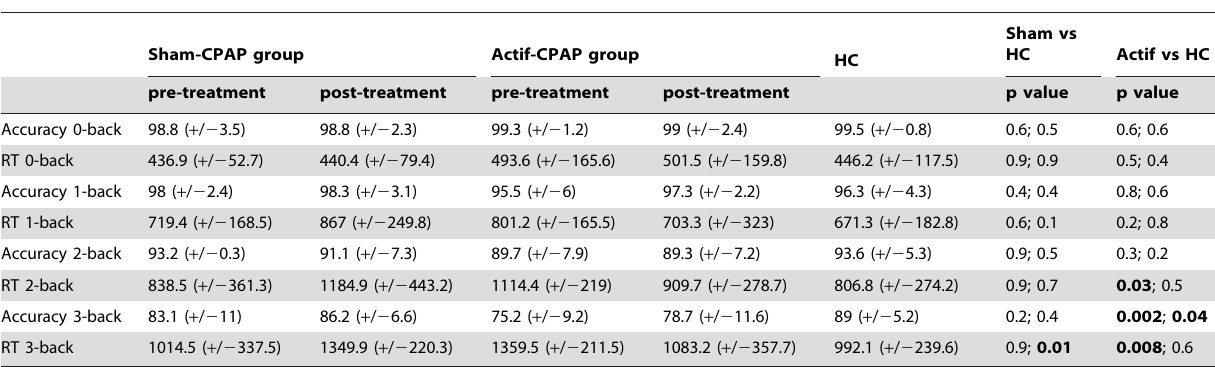
Table 2. Behavioral